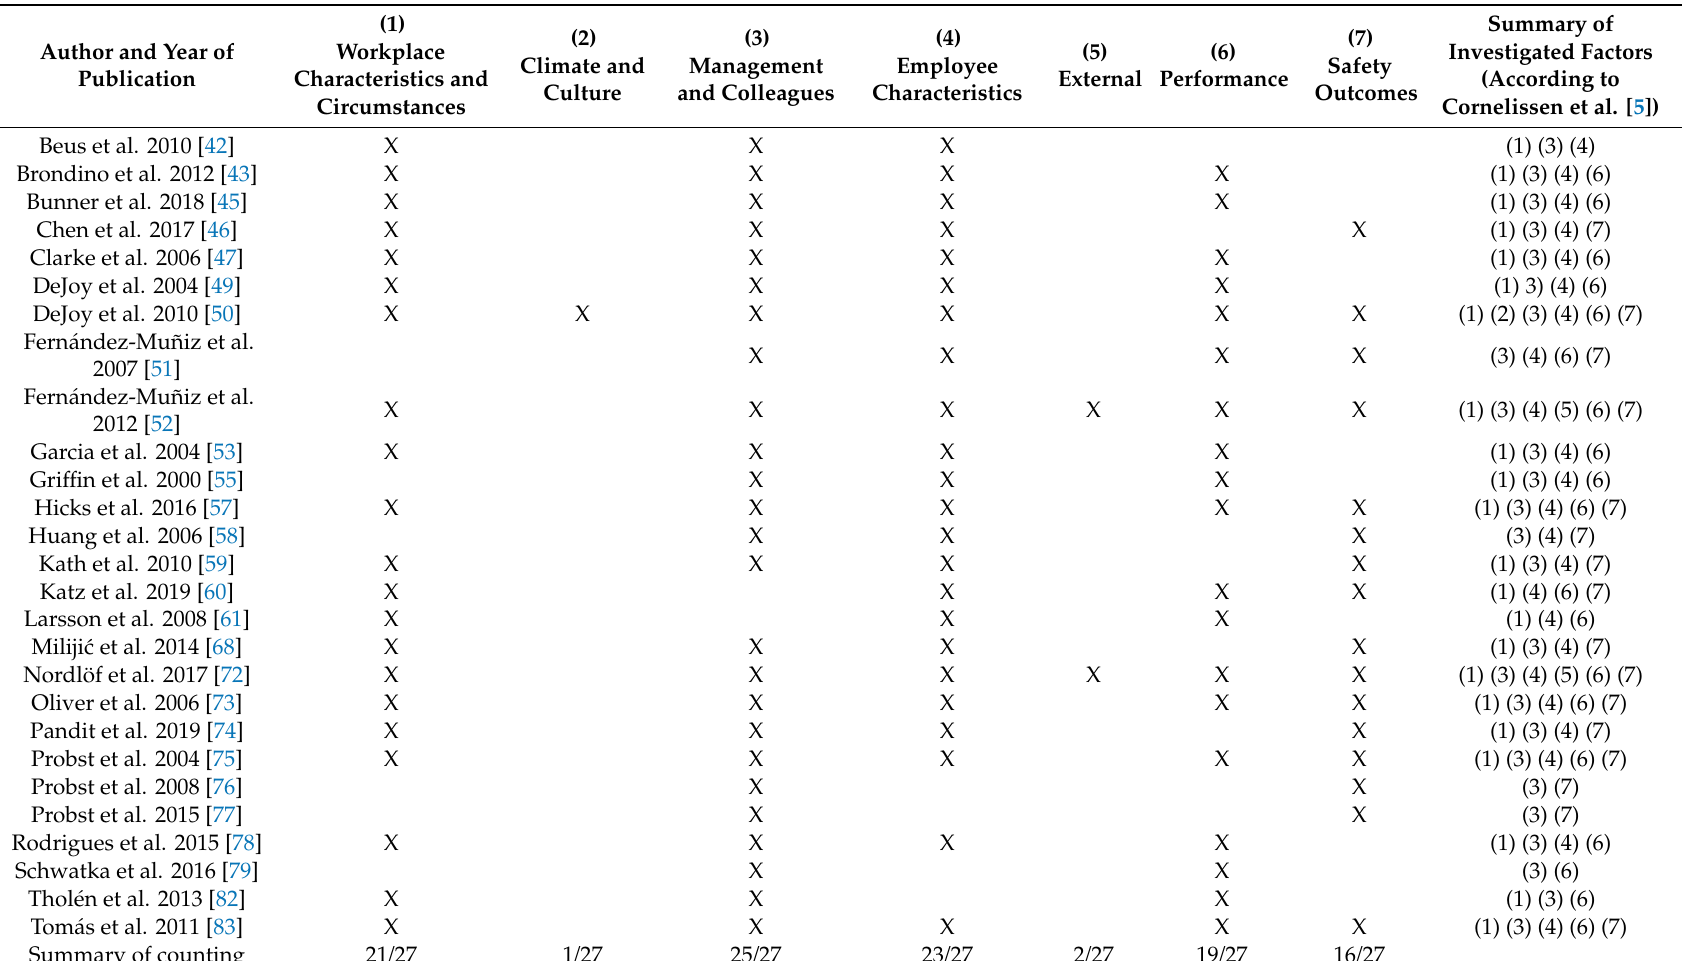
Table 3. Other workplaces—27 studies—mapping of the investigated determinants to clusters according to Cornelisson et al. [5] (for details of the studies see Table S5 in Supplementary Material, for topics and categories of the clusters see Table